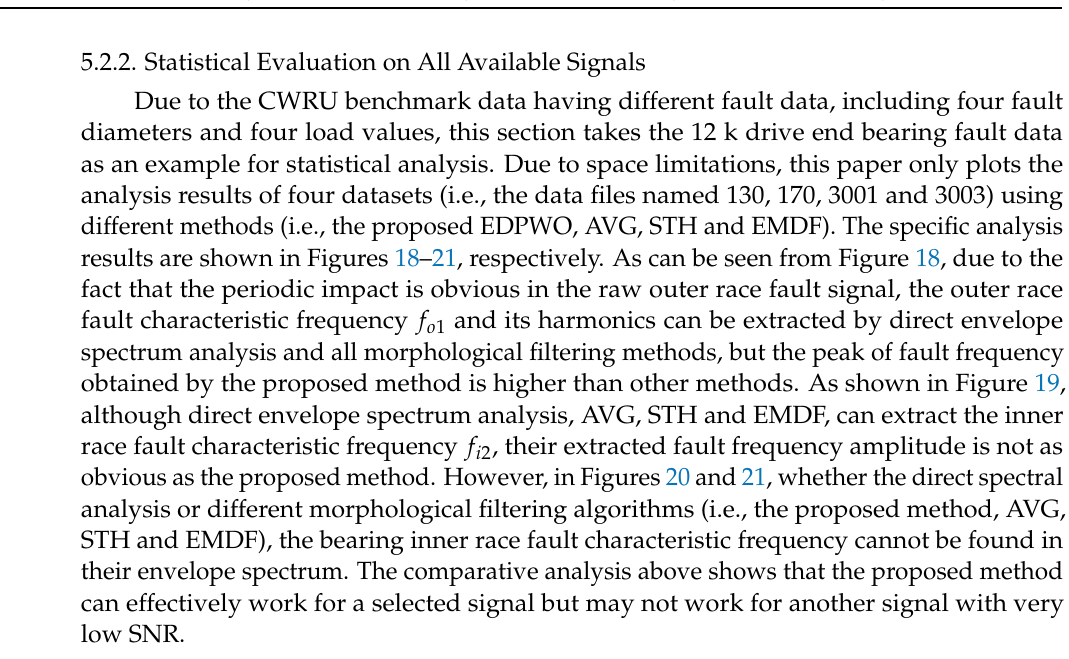
Figure 19. Analysis results obtained by different methods for dataset 170 in case 2: ( a ) Time domain waveform; ( b ) its corresponding envelope spectrum.